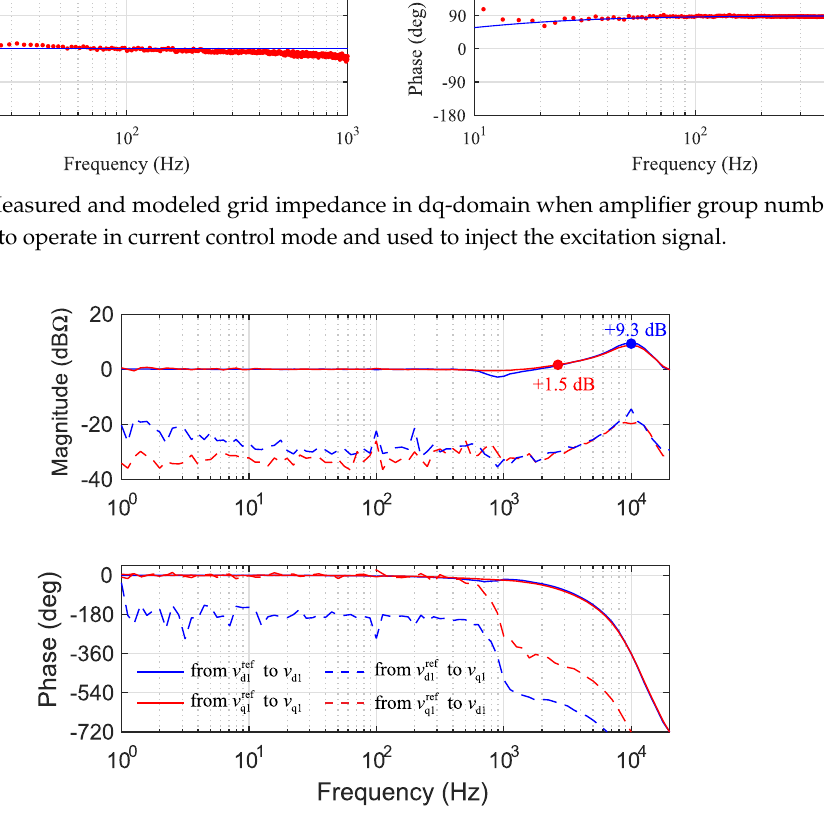
Figure 7. Measured frequency response of amplifier injection input to output in